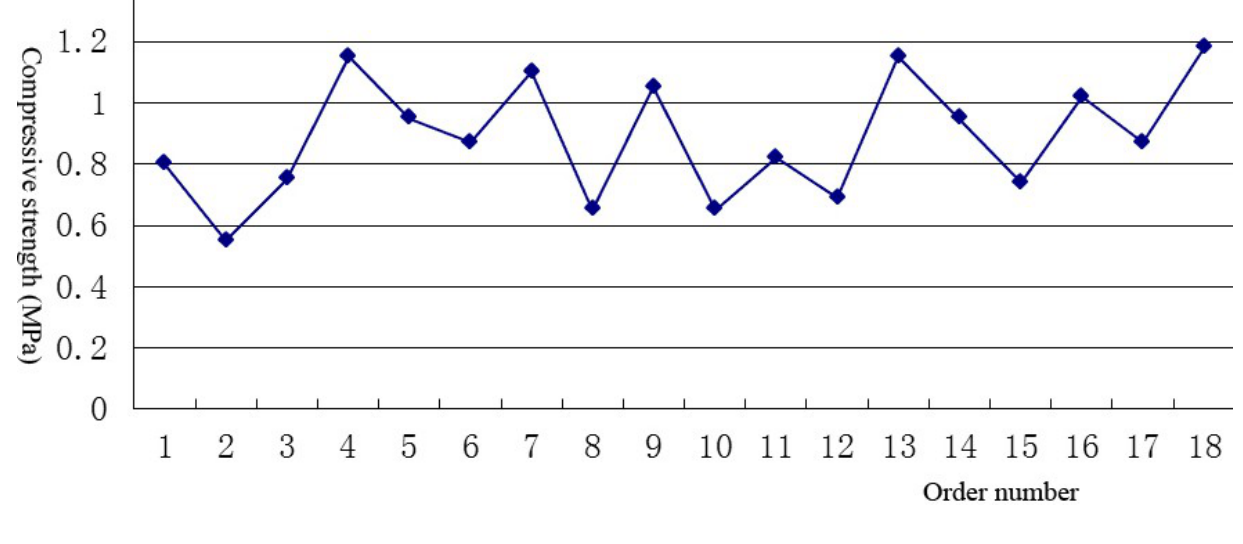
Table 5. Statistical evaluation of the compressive strength test results for the hardened layer of an antifouling